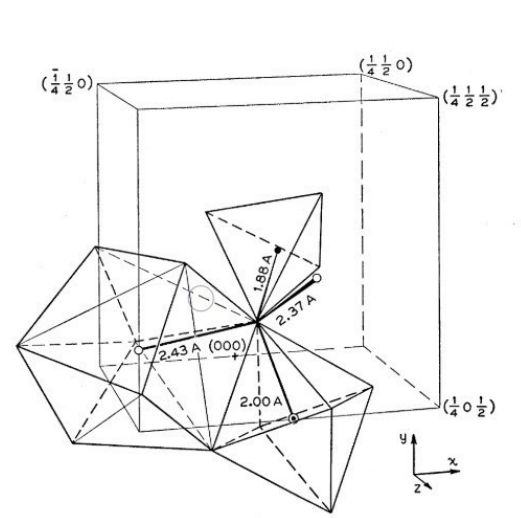
Figure 1. Structure of yttrium iron garnet (YIG) lattice with dodecahedra, octahedra, and tetrahedra from larger to smaller-size order 6 .